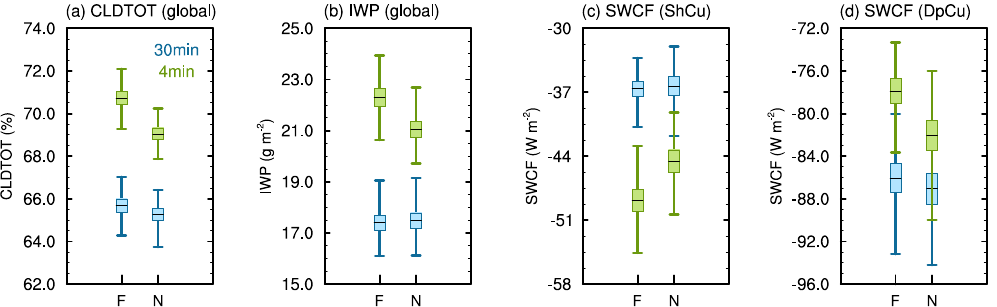
Figure 8. Comparison of the free-running (F) and nudged (N) simulations performed with 30min (blue) and 4min (green) time steps. Meanings of the whiskers, boxes, and hinges are the same as in Figs. 4 and 7. Each ensemble consists of 50 independent members. In the nudged simulations, temperature and horizontal wind were relaxed, using a nudging time scale of 6h towards those from the unconstrained simulations that used 30min time steps. Panels (a) and (b) show the globally averaged, vertically integrated total cloud fraction and ice water path, respectively. Panels (c) and (d) show the shortwave cloud forcing (SWCF) averaged over the shallow and deep convection regions. SWCF associated with shallow convection is the average over ocean grid points between 30 ◦ N and 30 ◦ S, where the frequency of occurrence of shallow convection is larger than 0.5, and the daily mean convective precipitation rate is lower than 1mm day − 1 . SWCF associated with deep convection is calculated in the same way as in Fig. 7 (cf. Sect. 3.3.2). All results are shown for the third simulation day.